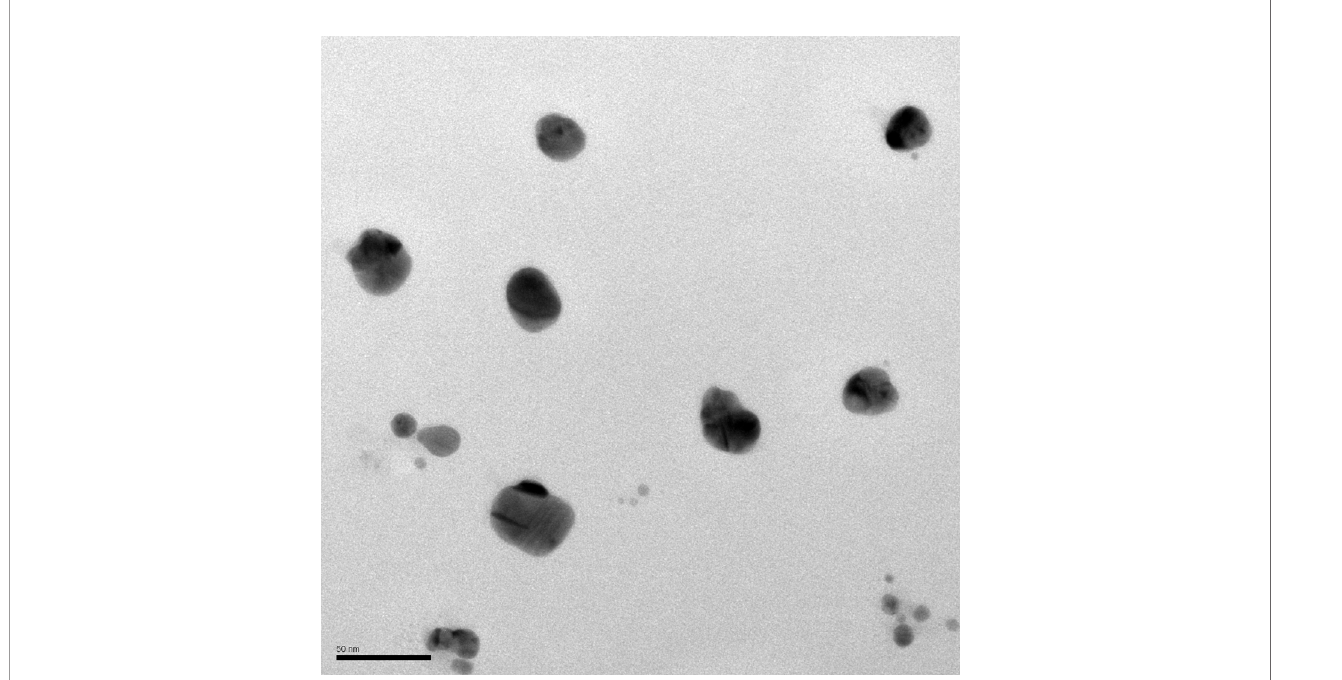
FIGURE 2 | Characterization by transmission electron microscopy (TEM) of bio-AgNP synthesized by Fusarium oxysporum (300,000×).